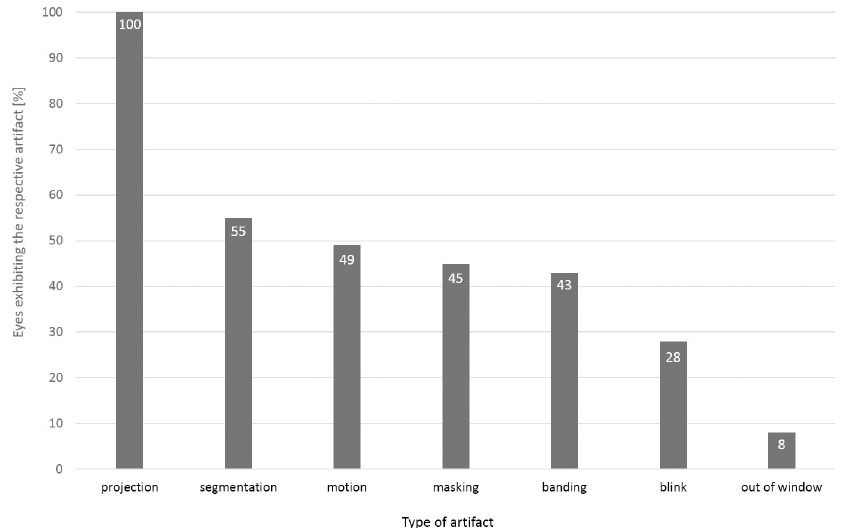
Fig 2. Different types of identified artifacts and their relative frequencies per entire OCTA